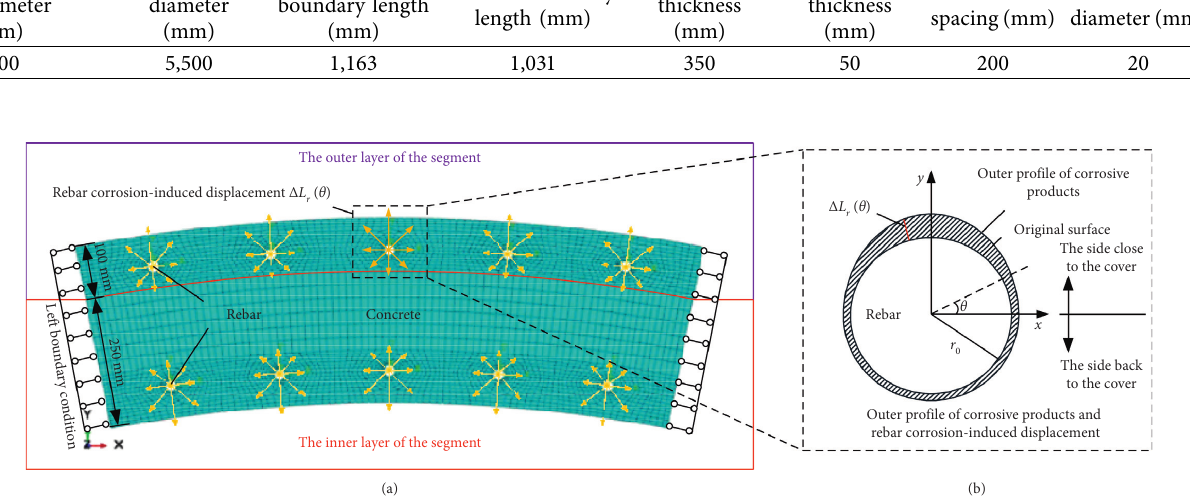
Figure 9: Numerical model of K-block: (a) outer and inner layer of the segment model and the boundary conditions and (b) outer profile of steel bar corrosive products. Table 4: Mechanical parameters of segment concrete for the inner and outer